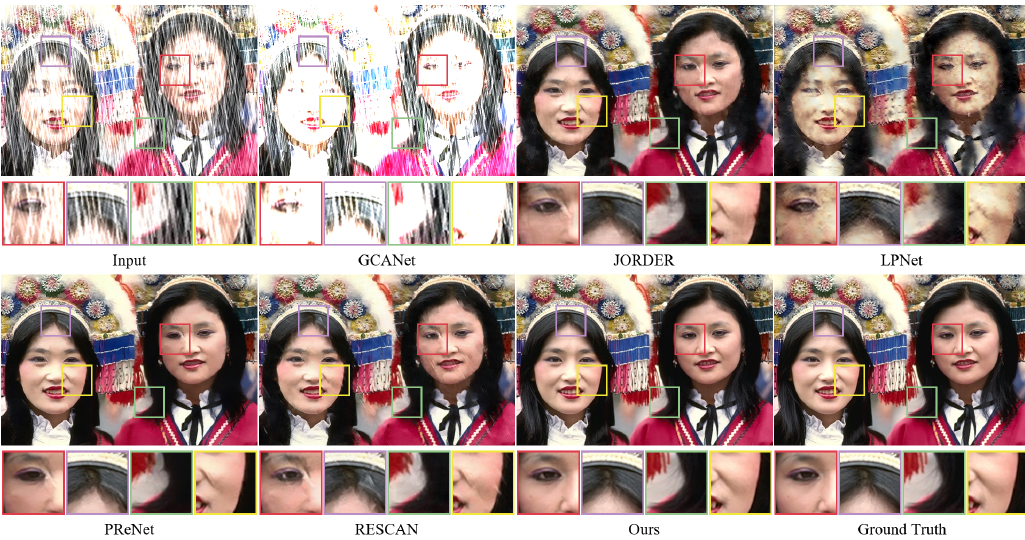
Figure 6. The performance of different methods on synthetic dataset